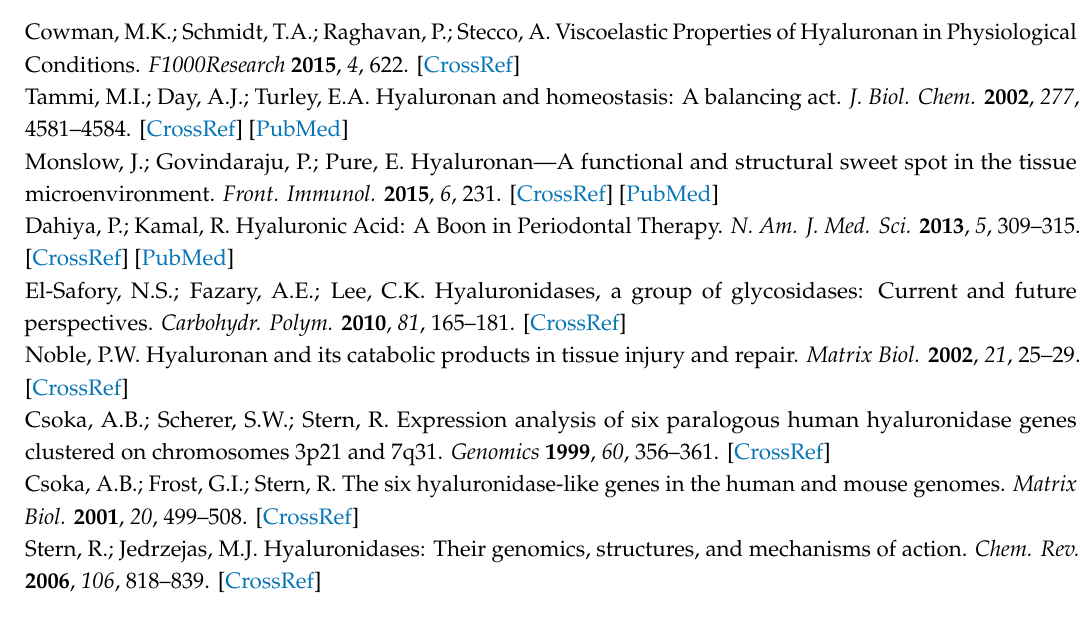
Figure S1: Calibration curve—Stains-all method. Table S1: Structure and inhibition values of testosterone derivatives, Table S2: Structure and inhibition values of dihydrotestosterone derivatives, Table S3: Structure and inhibition values of cinnamic acid